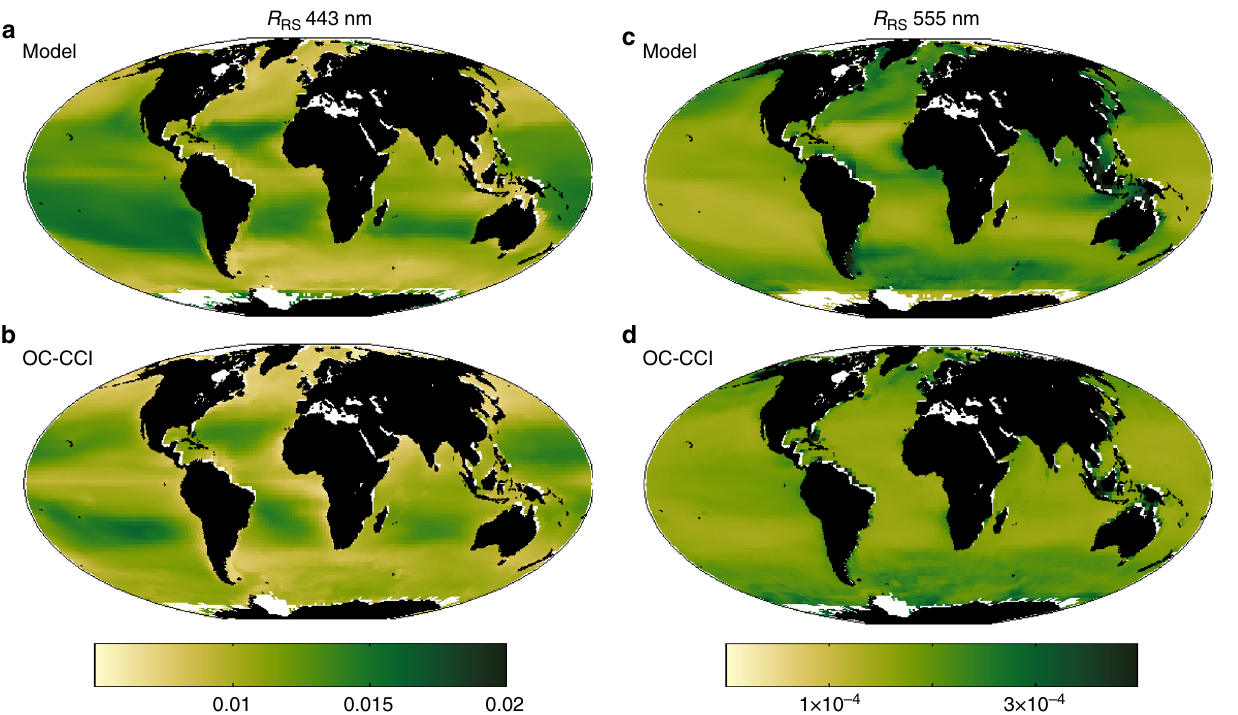
Fig. 2 Remotely sensed re fl ectance. Current day composite (1998 – 2015) for a model R RS interpolated to 443 nm, b observed R RS at 443 nm, c model R RS interpolated to 555 nm, and d observed R RS at 555 nm. Units are sr − 1 . Observed fi elds are from the Ocean Colour Climate Change Initiative (OC-CCI) project. White areas are regions where model resolution is too coarse to capture the smaller seas or regions of constant ice cover. Statistics of comparison of model and all six observed wavebands are provided in Supplementary Figs. 1,